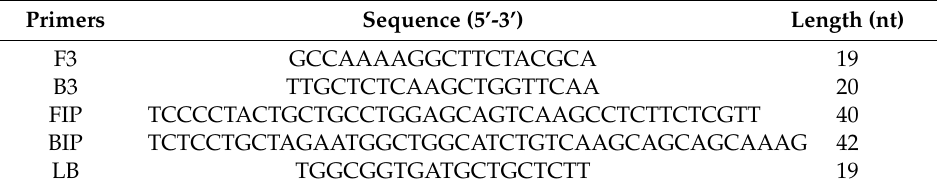
Table 1. Primer information of the novel SARS-CoV-2 RT-LAMP